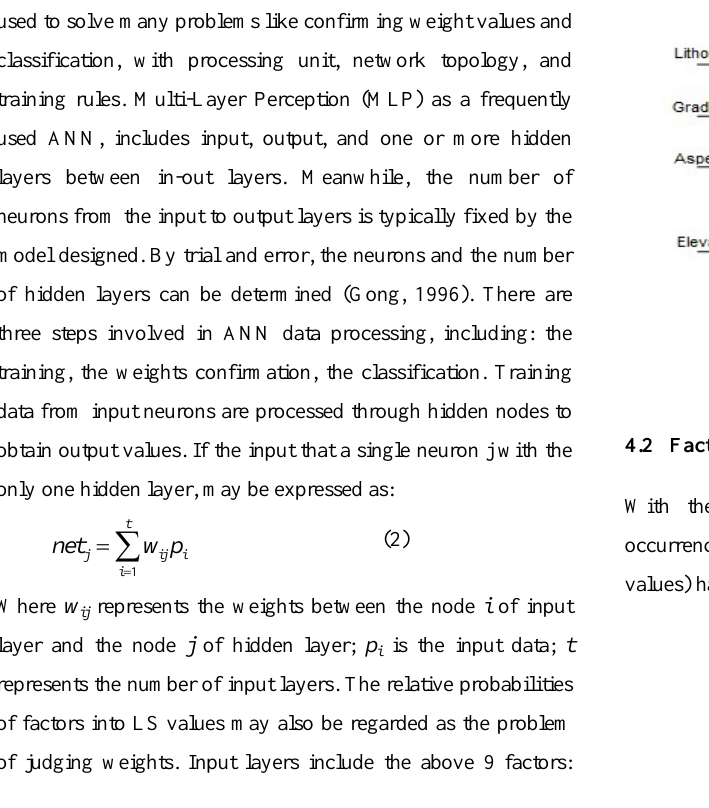
Table 3 Occurrence frequencies of different input factors